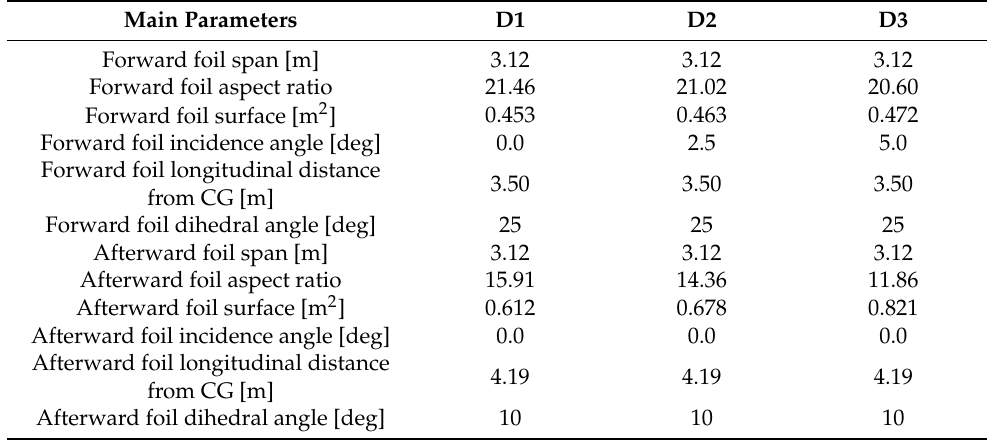
Table 2. Main properties of selected foil configurations.